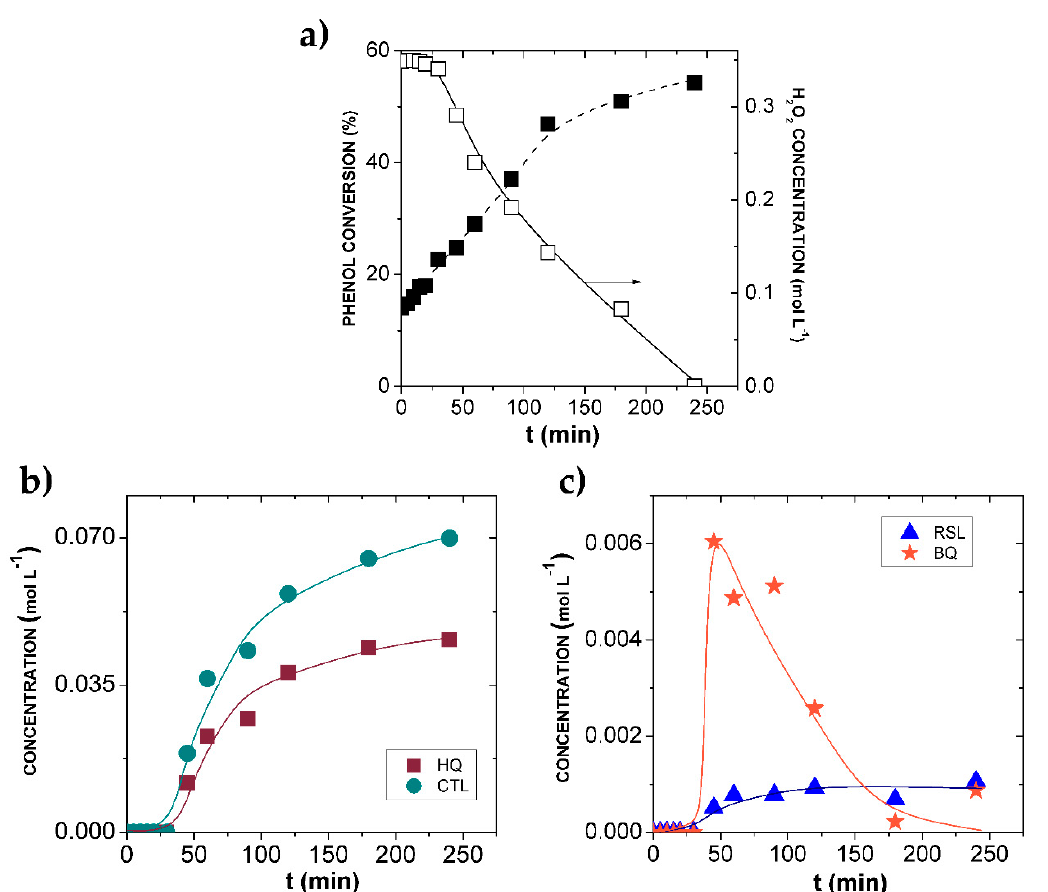
Figure 3. Results of the hydroxylation of phenol over Fe-BTC in a batch reactor. ( a ) Temporal profiles of phenol conversion and H 2 O 2 concentration; ( b ) temporal profiles of CTL and HQ (c) and BQ and RSL concentration. Operating conditions: [Phenol] 0 = 0.35 mol L − 1 , [H 2 O 2 ] 0 = 0.35 mol L − 1 , T = 20 °C, W FeBTC = 0.010 g.